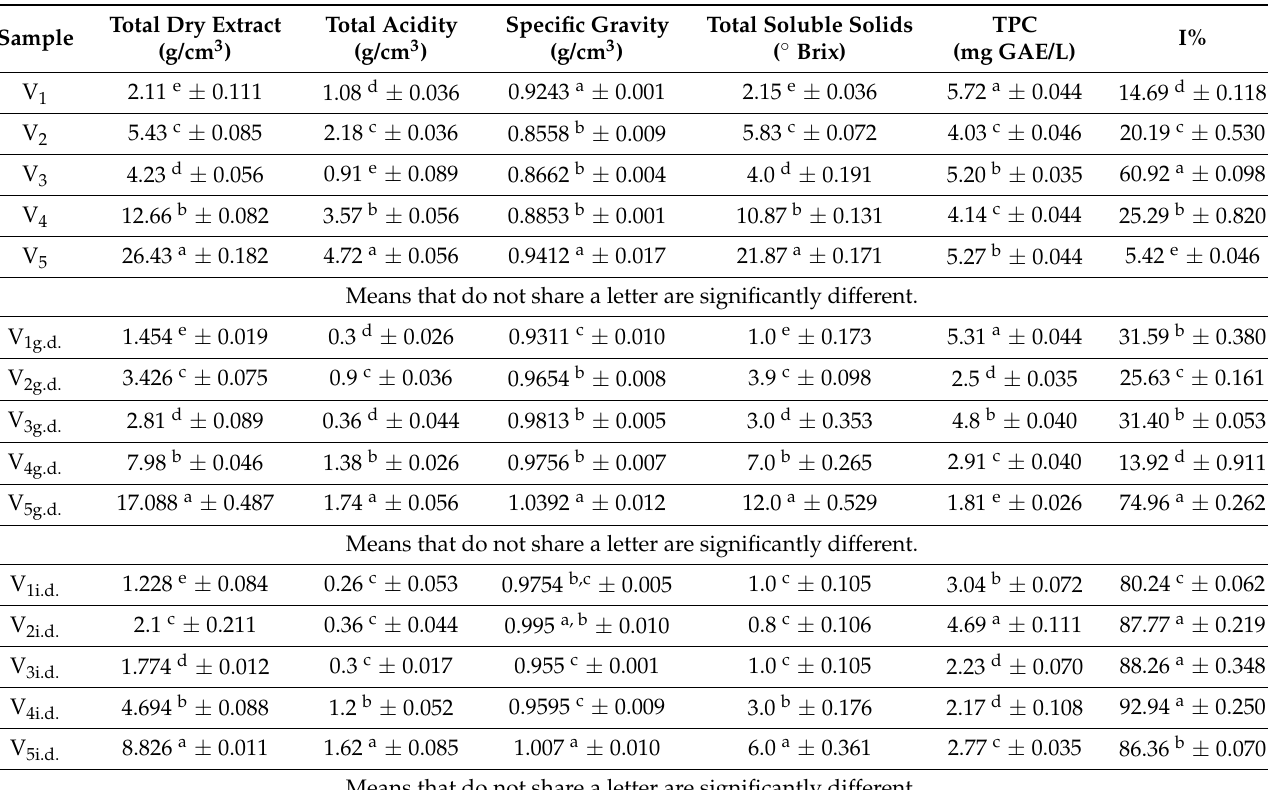
Table 1. Physic and biochemical properties of banana peel and commercial balsamic vinegar before and after in vitro digestion. Total Dry Sample